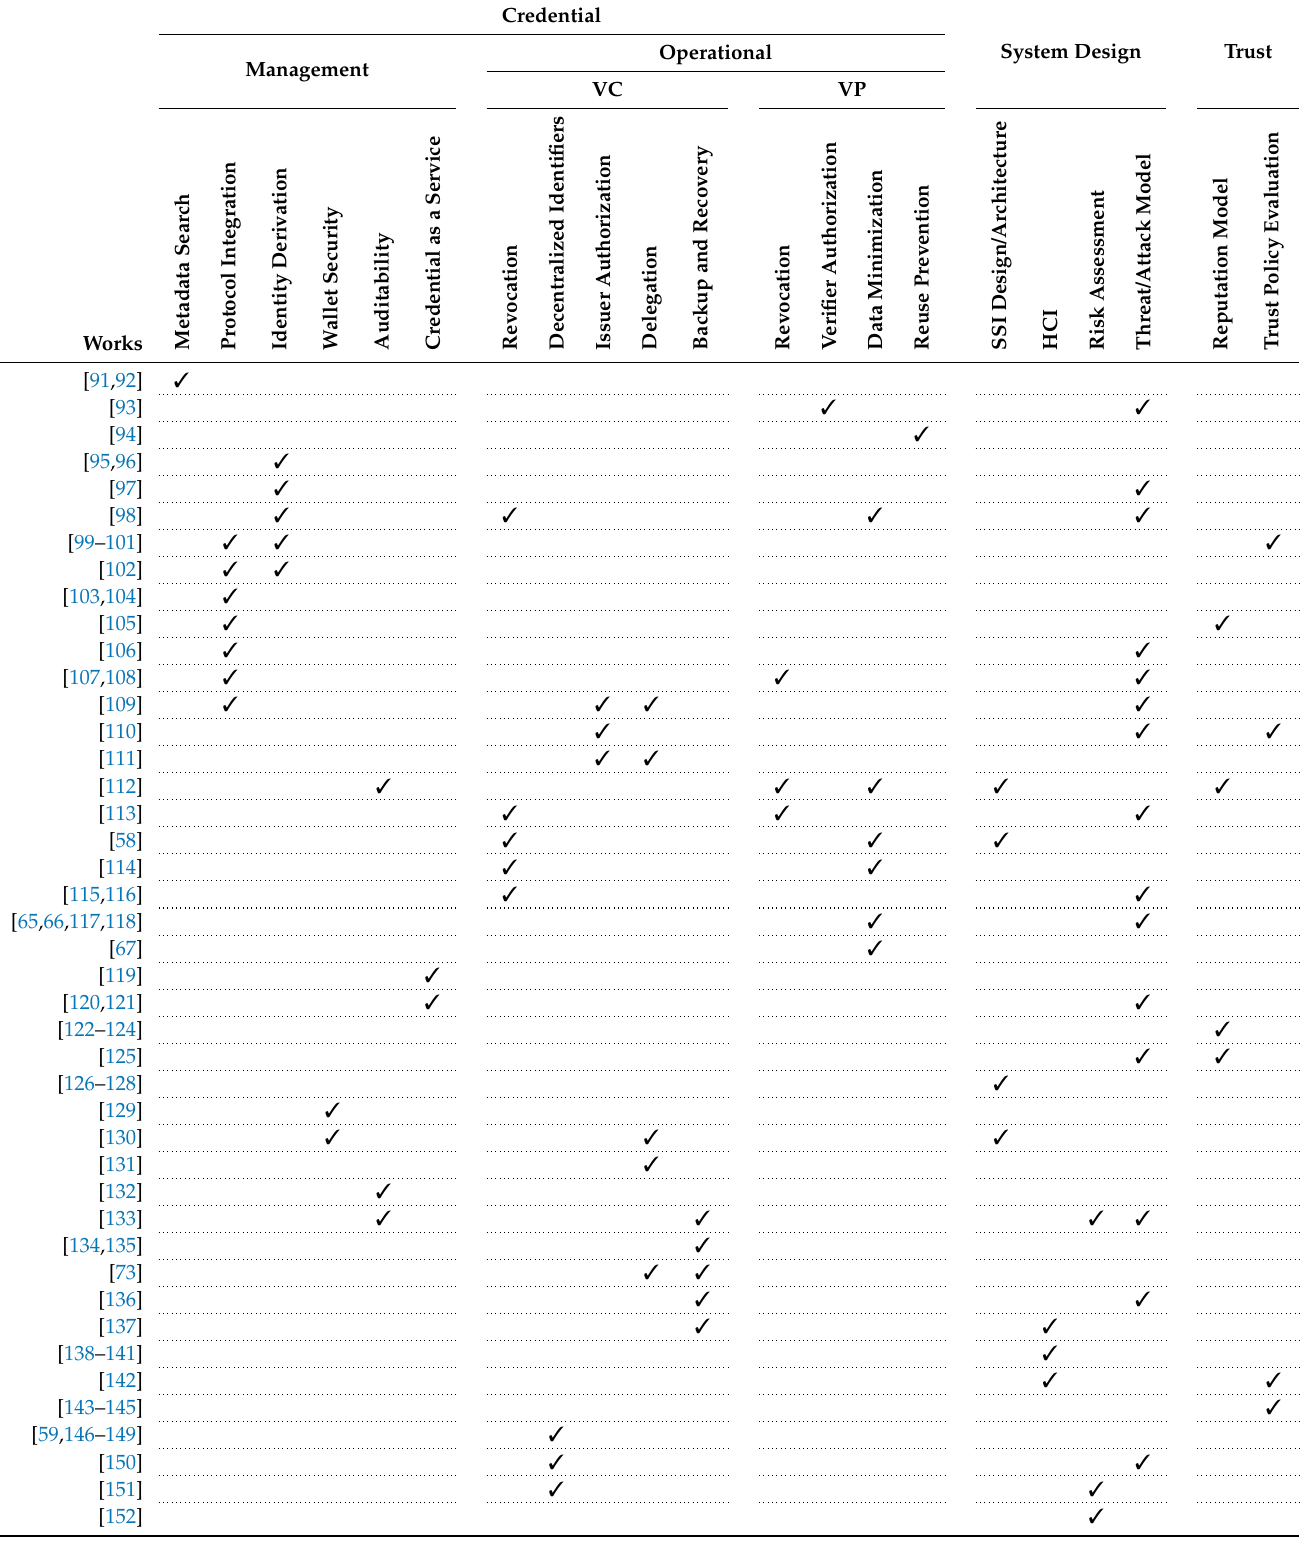
Table 5. Publications that introduced and solved novel problems in the SSI